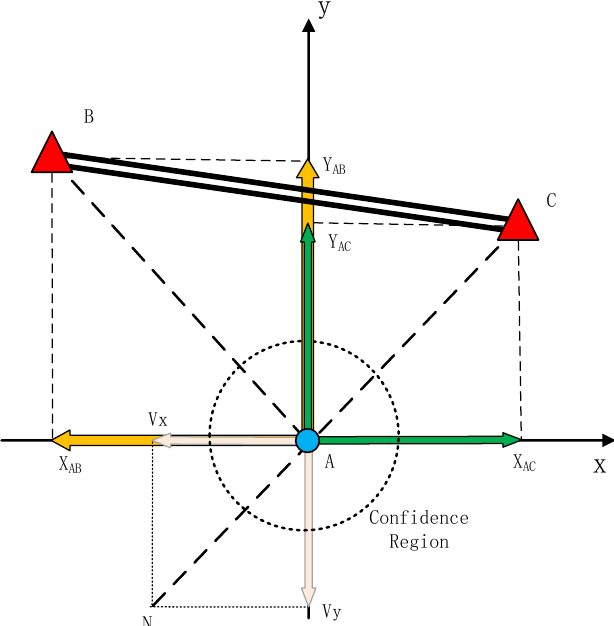
Figure 2. Demonstration of the enclosure condition in the triangle.